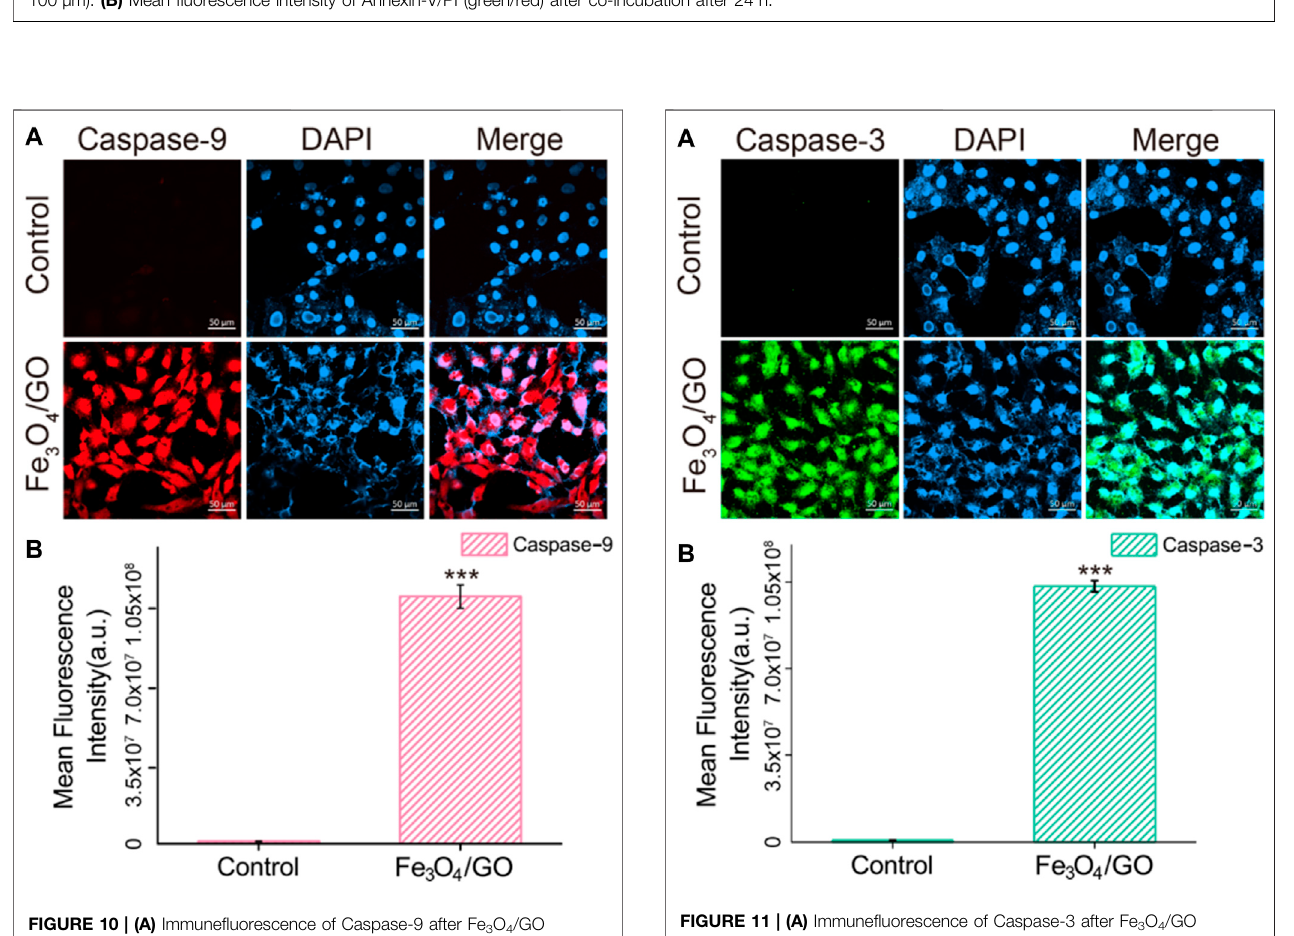
FIGURE 10 | (A) Immune fl uorescence of Caspase-9 after Fe 3 O 4 /GO exposure. (scale bar: 50 μ m) (B) Mean fl uorescence intensity of Caspase-9 after Fe 3 O 4 /GO nanoparticle exposure.